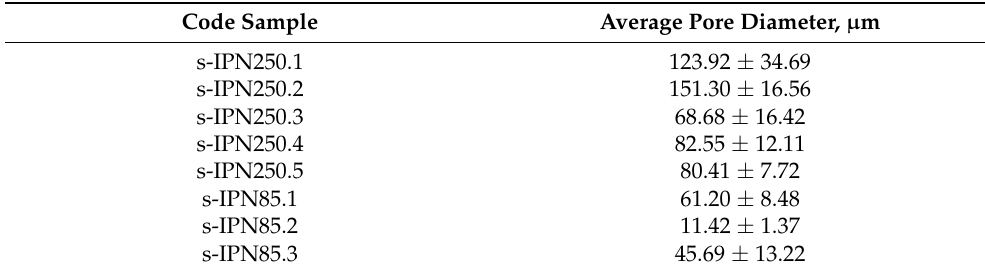
Table 3. Morphological characterization of the semi-IPN cryogels as a function of the PDMAEMA molar mass and synthesis conditions (according to Table